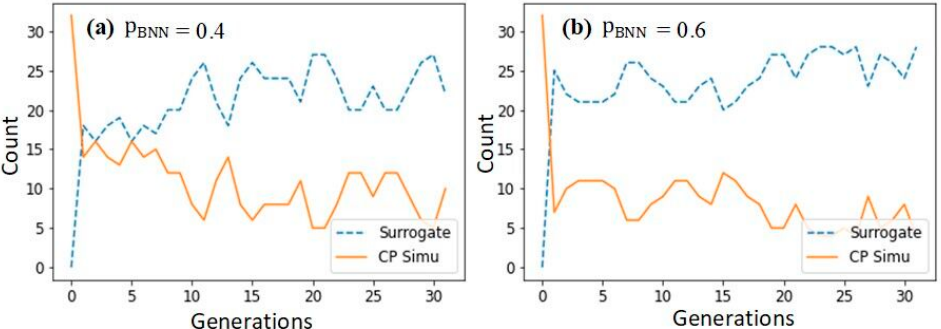
Figure 10. The number of phenomenological CP simulation calls and surrogate (the BNN or Lookup) calls in GA generations ( a ) p BNN = 0.4, ( b ) p BNN = 0.6 .